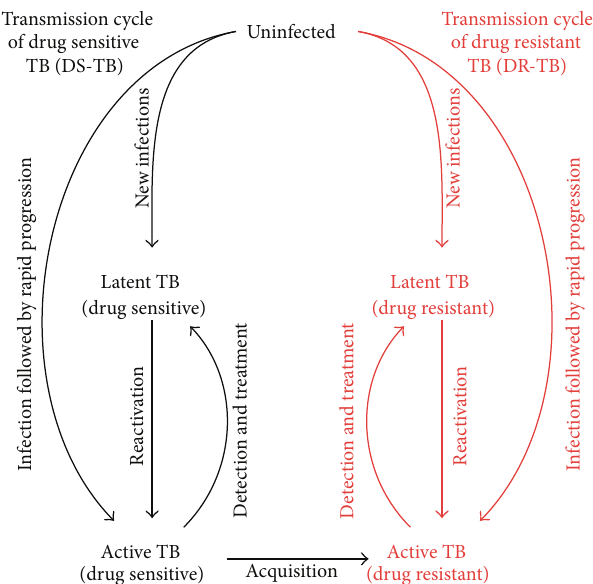
Figure 3: A simple epidemiological model of drug resistant (DR-)TB. This model divides the transmission cycle of TB into two arms: transmission of DS-TB and DR-TB (which is shown in red). For simplicity and comparability, the transmission cycle of DR- TB is structurally similar to DS-TB. The difference between DS-TB and DR-TB can be characterized by difference in rates of transition between different compartments. (E.g., if the transmission fitness of DR-TB is less than that of DS-TB, the rates of new infections of DR- TBarelowercomparedtoDS-TB.)Theacquisitionofdrugresistance during treatment resulting from de novo mutations is a primary way in which drug resistance enters the population. Subsequently, drug resistance can spread via transmission events. Increasing the rate at which DR-TB is successfully diagnosed and treated (e.g., through drug susceptibility testing and regimen modification) can be modeled as an increase in the flow from compartment “Active DR-TB” back to “Latent DR-TB” (or, in an alternative formulation, back to